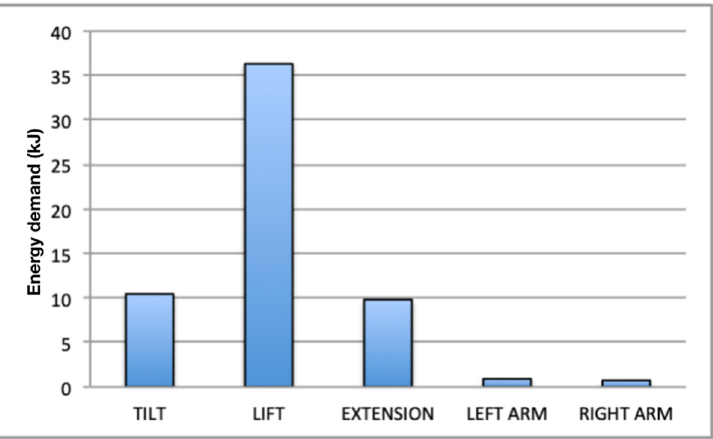
Figure 6. Energy demand of the actuators.